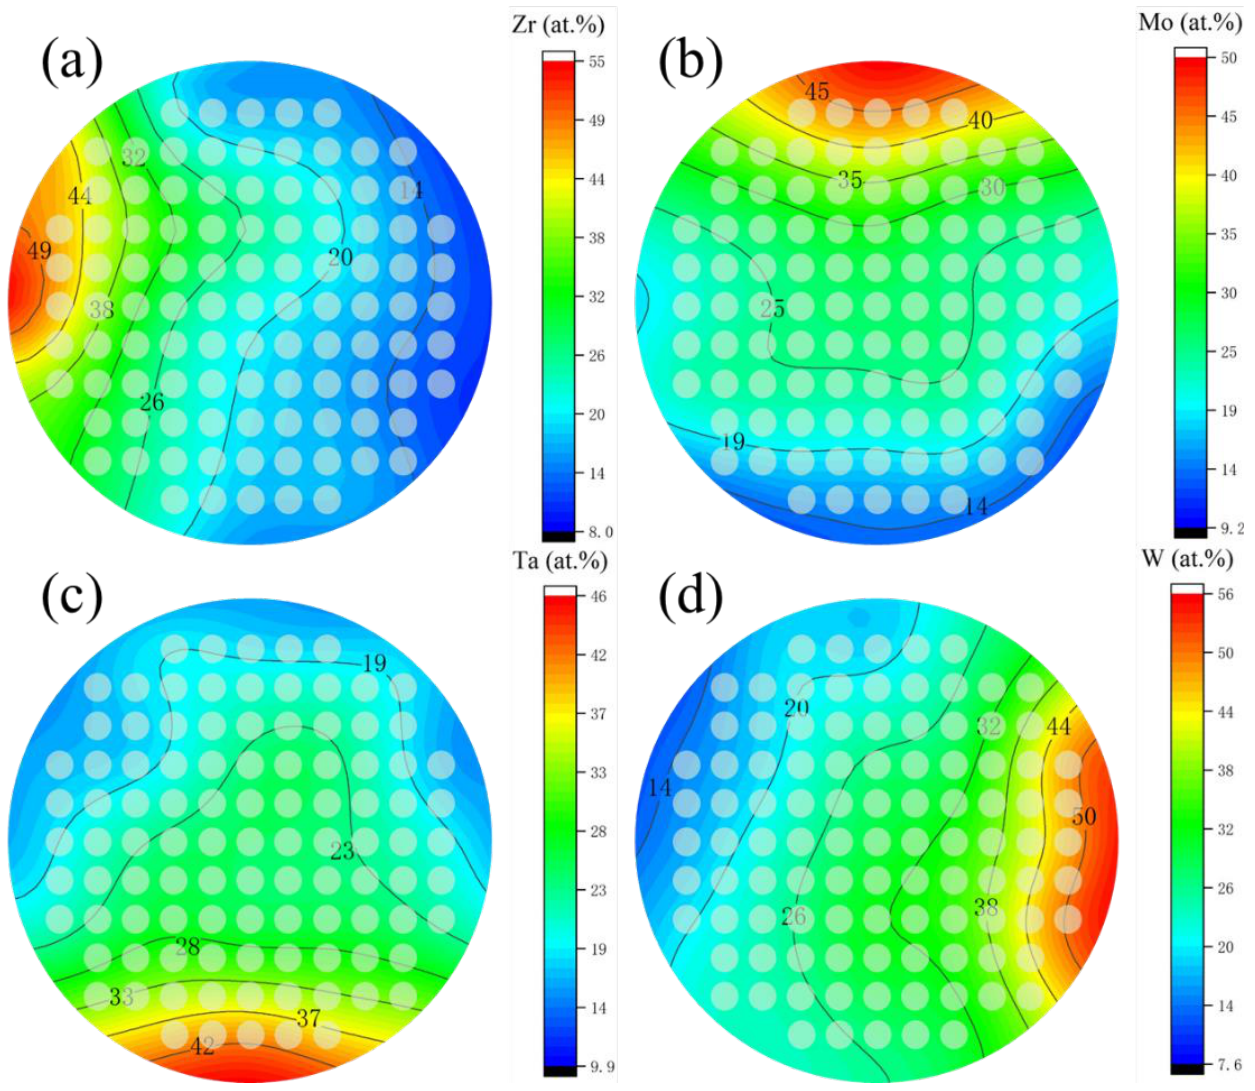
Figure 3. Composition gradients of ( a ) Zr, ( b ) Mo, ( c ) Ta, and ( d ) W of thin film.